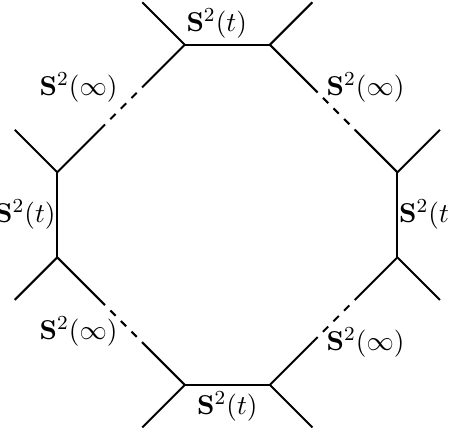
Figure 13 . Toric diagram for R (cid:8) q obtained by connecting the toric diagrams of resolved conifolds, each with an S 2 having K(cid:127)ahler parameter t , by connecting their vertices using in(cid:12)nitely long lines. The dashed lines are meant to represent in(cid:12)nity long two-cycles, i.e., S 2 s having t = 1 .